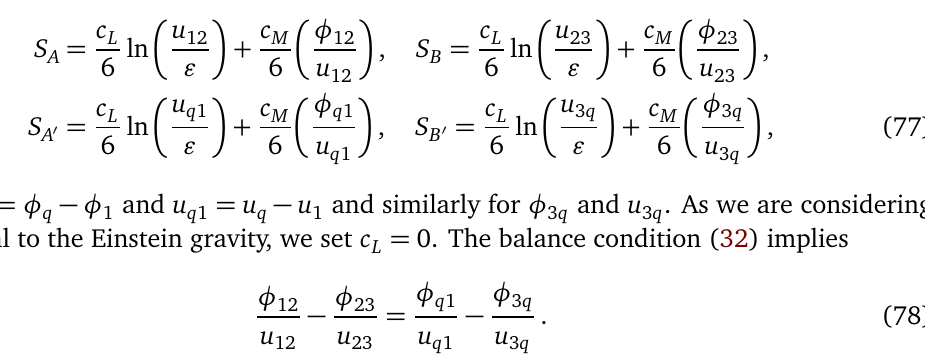
are the null i is just a point on γ . The figures b 2